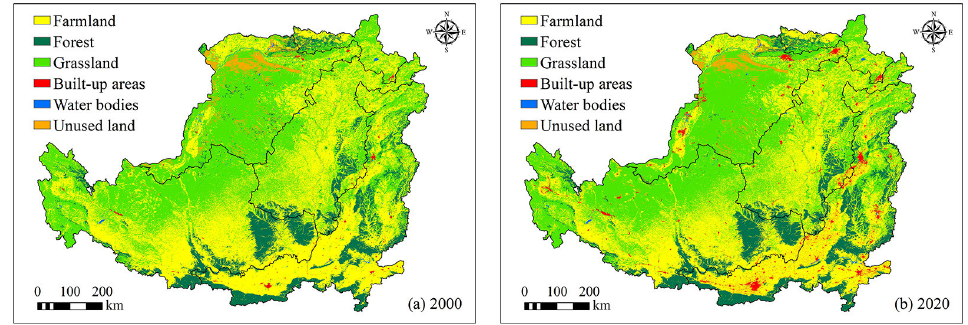
Figure 8. LUCC of the LP for 2000 and 2020: ( a ) land use/cover in the loess plateau in 2000; ( b ) land use/cover in the loess plateau in 2020. Table 4. LUCC in the LP from 2000 to 2020.